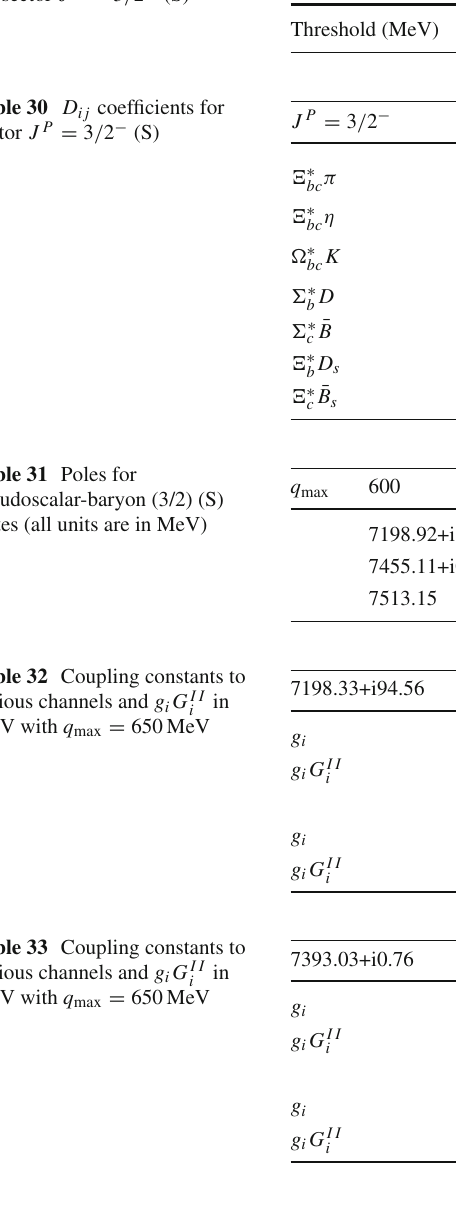
pled channels that can lead to these quantum numbers and in MeV i study their interaction in s -wave. The model used for the interaction is based on an extrapolation of the local hid- den gauge approach, which uses vector exchange as the source of interaction. The dominant terms come from the exchange of light vector mesons which render the heavy quarks as spectators and the approach automatically satis- fies the heavy quark symmetry rules. The interaction is prop- erly unitarized in coupled channels and by looking at poles in the second Riemann sheet we look for the states of